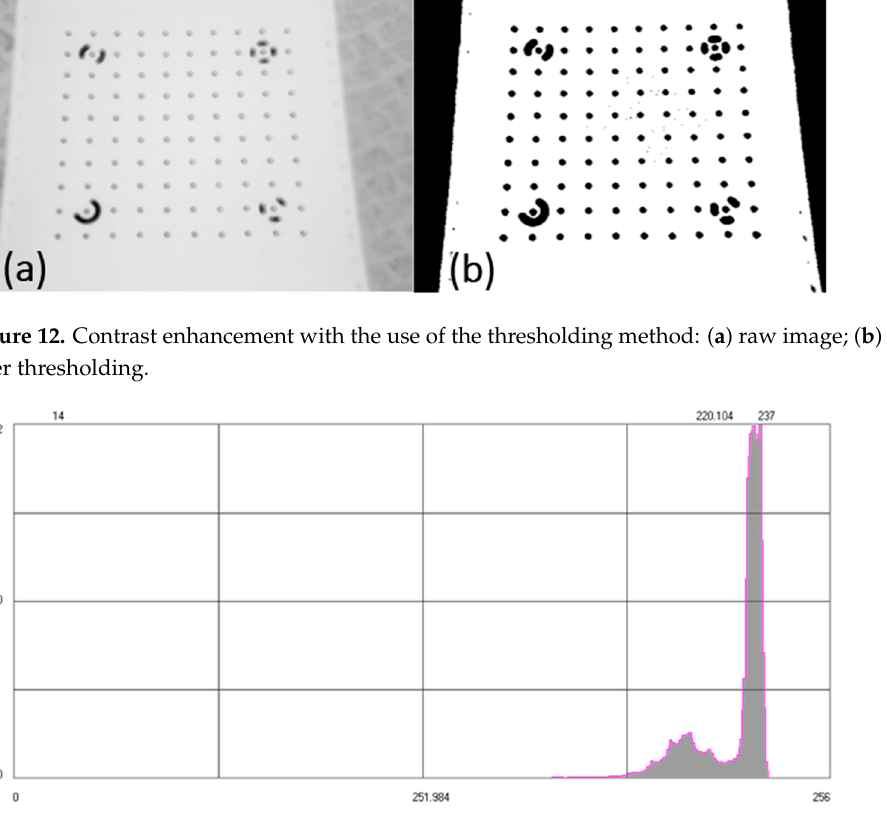
Figure 13. Histogram of the thermogram.